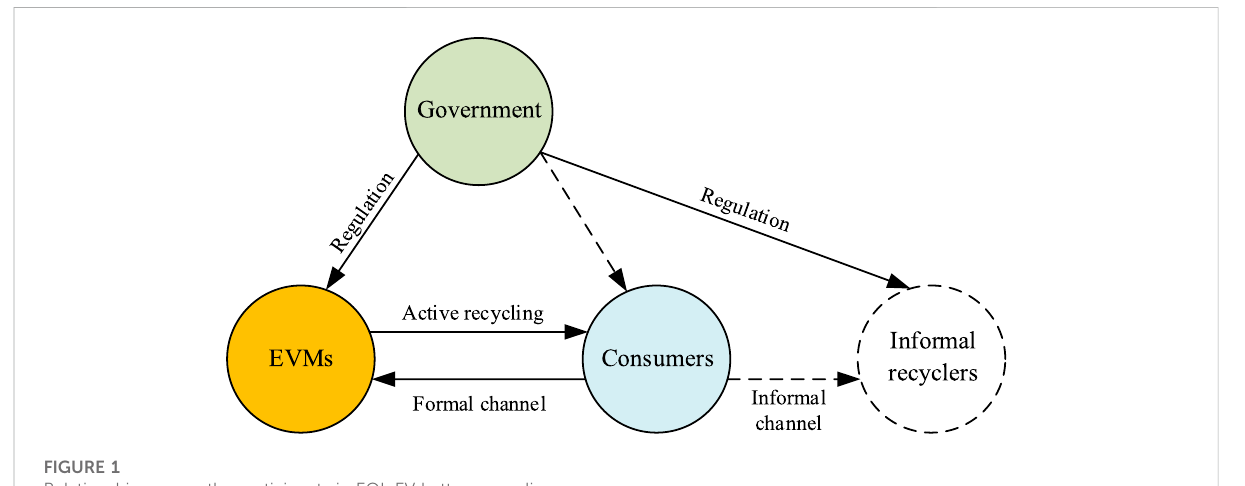
FIGURE 1 Relationship among the participants in EOL EV battery